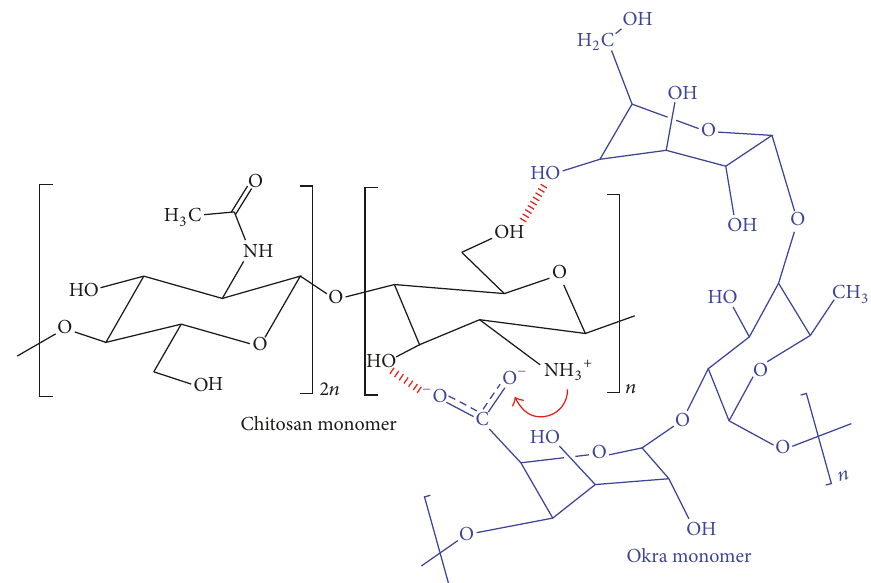
Figure 1: Electrostatic interactions between the monomers of OKG and CH.